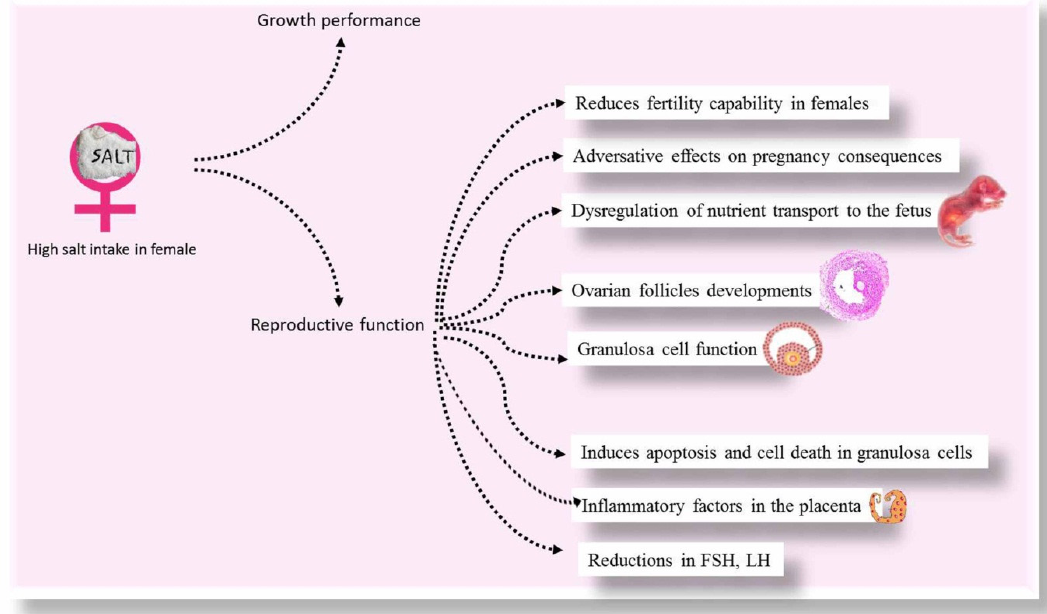
ff ect of high salt diet on female Figure 2. The adverse effect of high salt diet on female animals. Figure 2. The adverse e